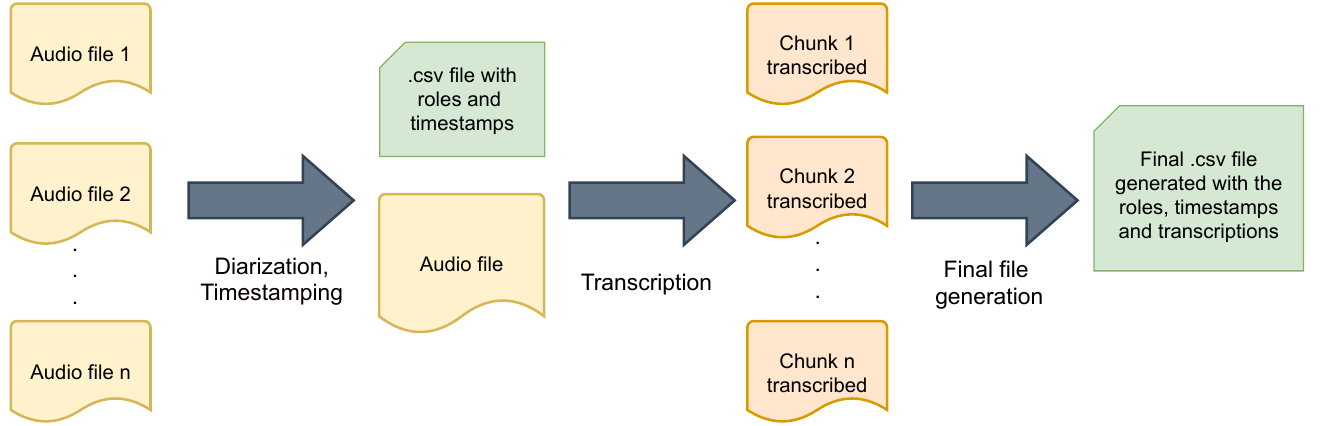
Figure 2. Data pre-processing schematic